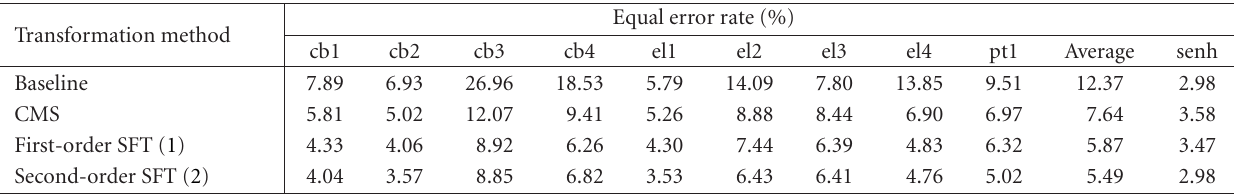
Table 2: Equal error rates (%) achieved by the baseline, CMS, and di ff erent transformation approaches. First-order and second-order SFT stand for first-order and second-order stochastic feature transformation, respectively. The enrollment handset is senh. The last column represents the case where enrollment and verification use the same handset. The average handset identification accuracy is 98.29%. Note that the baseline and CMS do not require the handset selector.